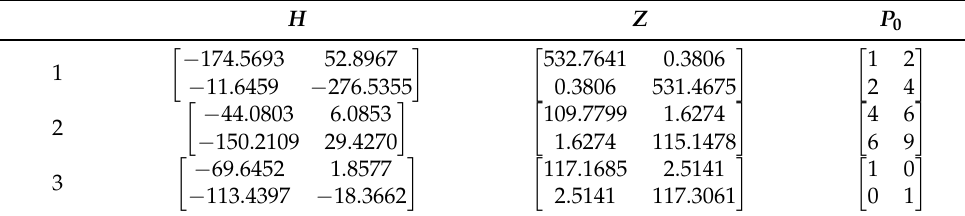
Table 2. Three sets of simulation results of LMI toolbox.